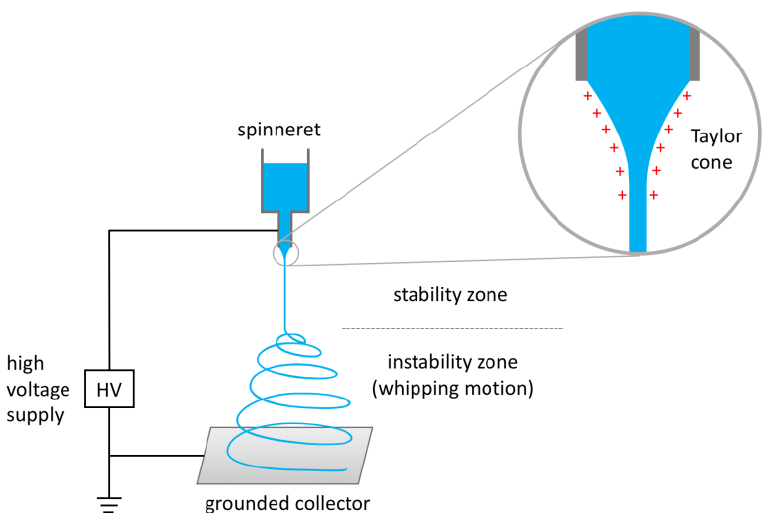
Figure 1. A typical electrospinning set-up, comprising: (i) A spinneret containing the polymeric solution; (ii) a DC high voltage supply; and (iii) a grounded collector. A charged jet of polymer solution is extracted from the spinneret tip (with a typical cone shape, in the inset) and reaches the collector with a typical whipping motion.